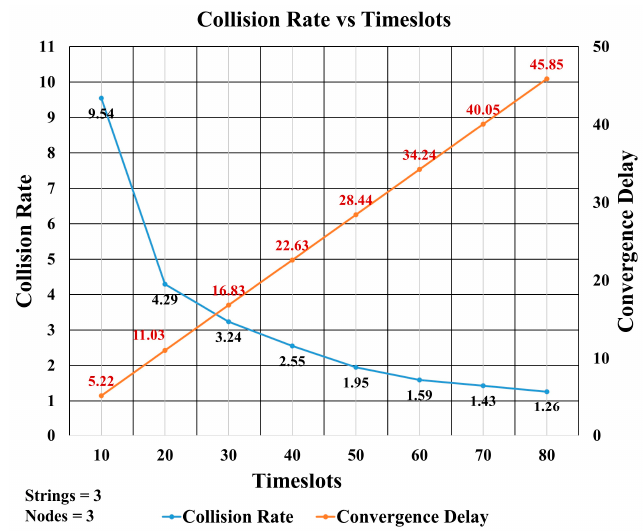
Figure 18. Collision Rate vs. Convergence Delay.